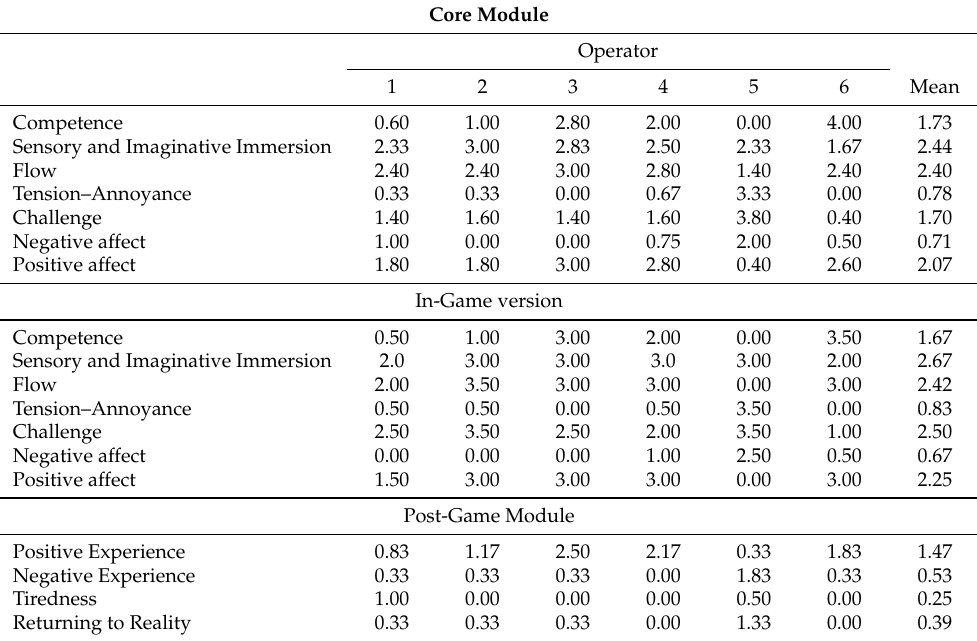
Table 6. Game Experience Questionnaire